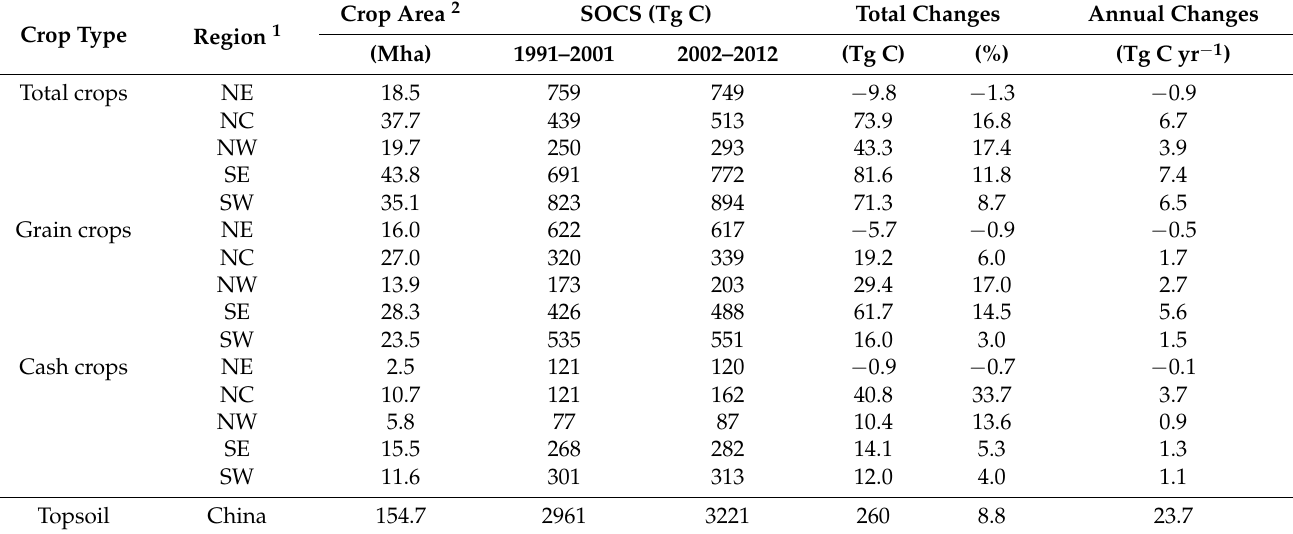
Table 4. Estimated changes of soil organic carbon stock (SOCS) between the 1991–2001 and the 2002–2012 from different geographical regions in China’s